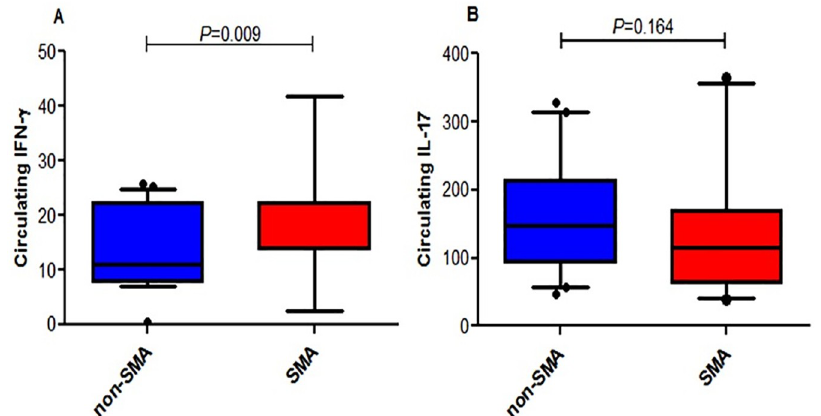
Fig 5. Circulating levels of IFN- γ and IL-17 in children with differing malarial anemia severity. Box-plots depict the data where the box represents the interquartile range, the line through the box is the median, and whiskersillustrate the 10th and 90th percentiles. CirculatingIFN- γ ( n = 64; non-SMA = 42; SMA = 22) and IL- 17 ( n = 64; non-SMA = 42; SMA = 22) concentrations were determinedin plasma using the human Cytokine 25-plex Ab Bead Kit, (BioSource ™ International) accordingto the manufacturer’s protocol. Plates were read on a Luminex100 ™ system (LuminexCorporation)and analyzedusing the Bio-Plex ManagerSoftware (Bio- Rad Laboratories). Betweengroups comparisons in the clinicalcategorieswere performed by Mann-Whitney U tests. (A) CirculatingIFN- γ levels betweennon-SMA and SMA. (B) CirculatingIL-17 levels betweennon- SMA and